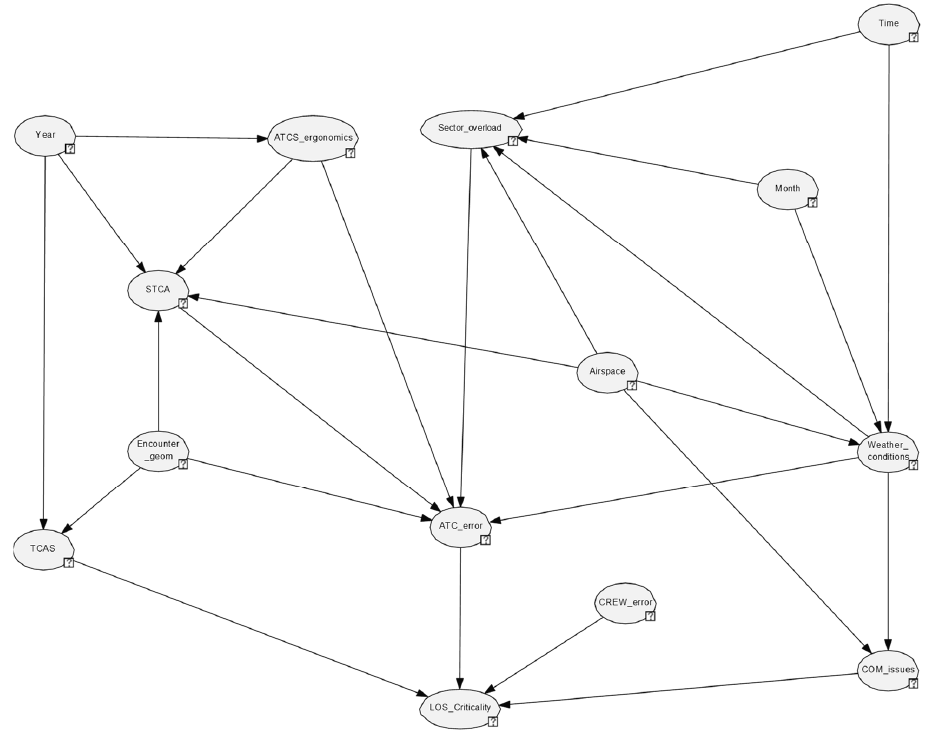
Figure 8. Expert-based BN architecture.